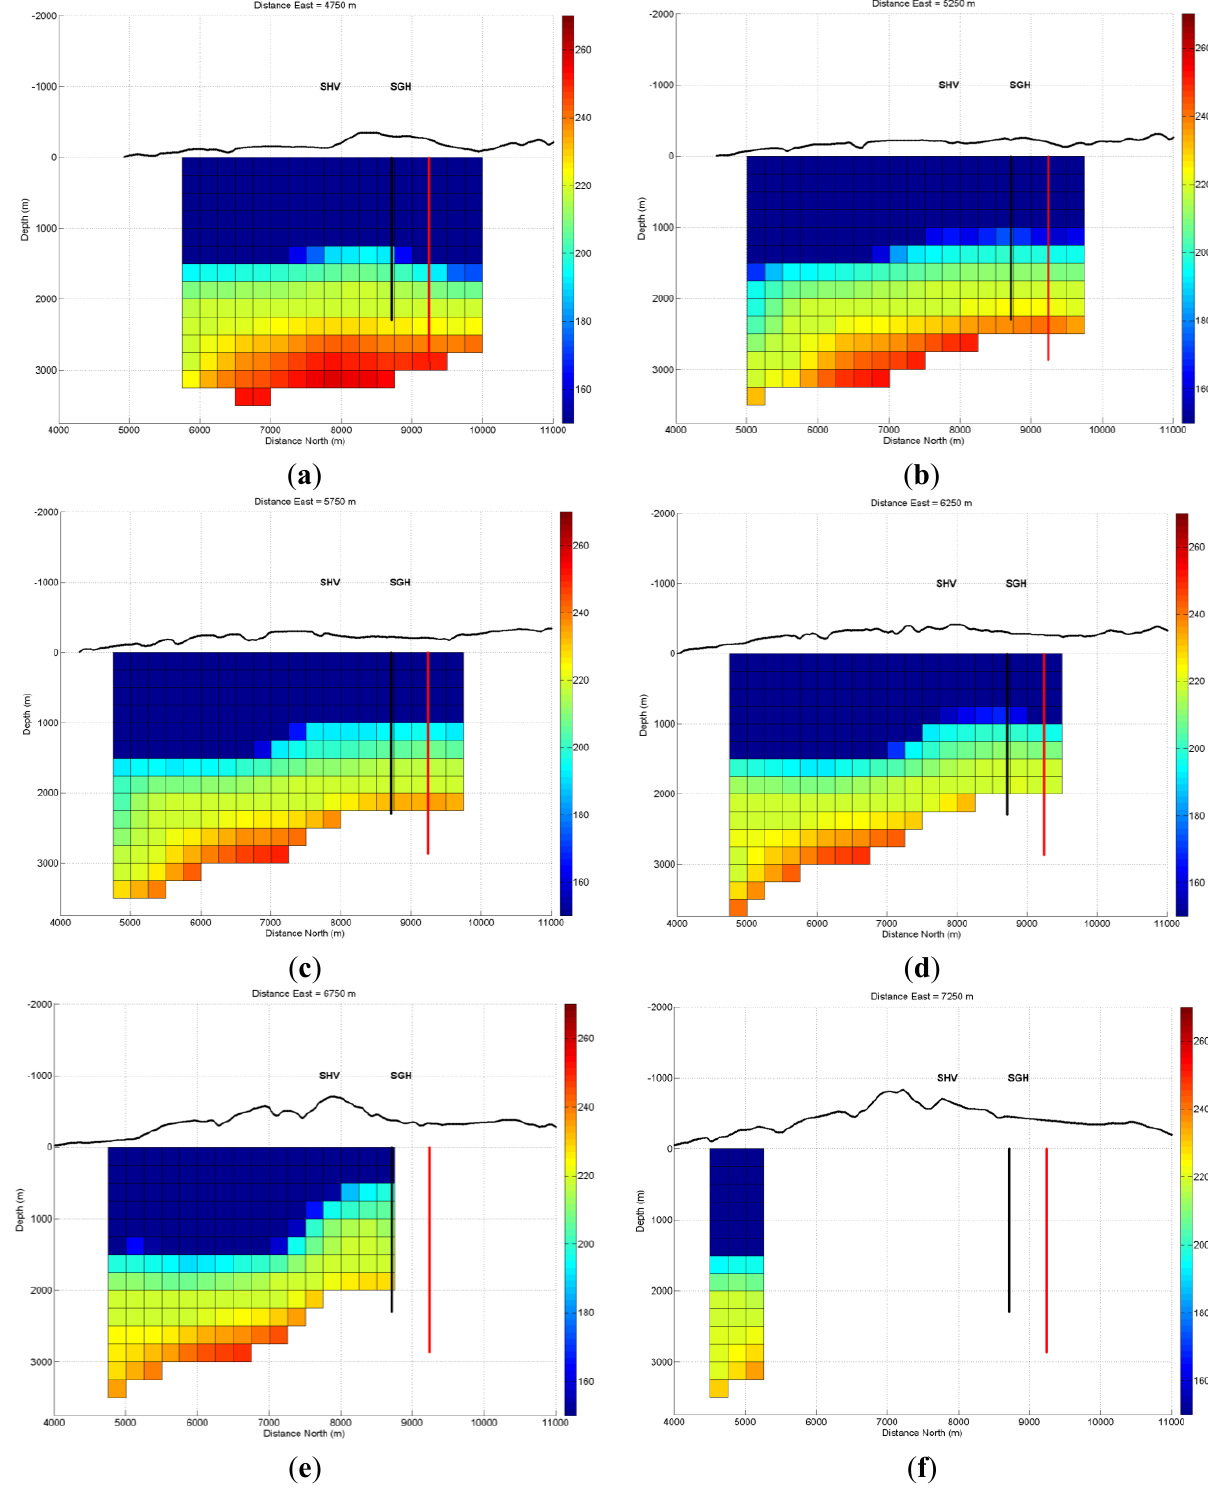
Figure 9. ( a – f ) N-S Cross-sections through the southwestern region of the temperature model estimated from the seismic velocity anomaly data. This region corresponds to seismic anomaly associated with the known geothermal system. Black line indicates the track of well MON-1 and the red line indicates the track of well MON-2. SHV (Soufrière Hills Volcano); SGH (St. George’s Hill). The colour scale indicates temperature in degrees